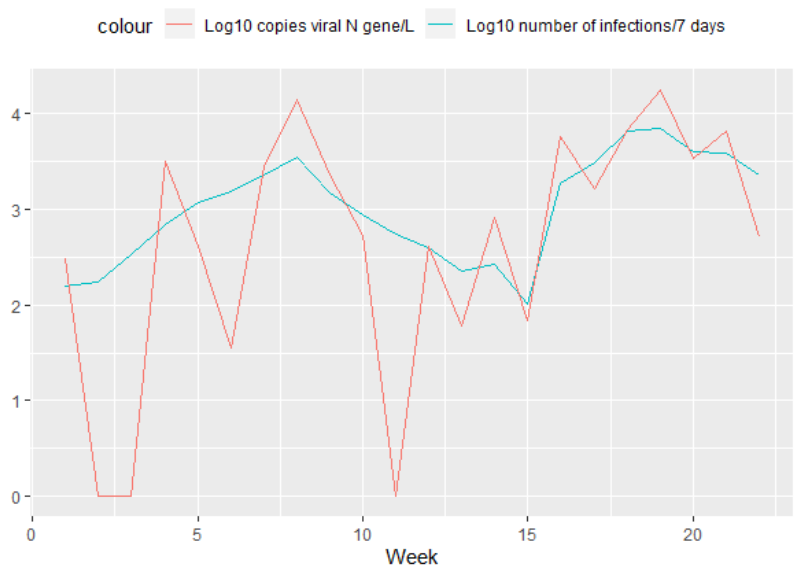
Figure 6. Log10 transformed amount of viral nucleic acid (N gene) detected in WWTP influent (red line) and the log10 transformed total number of infections that occurred during the week after the sampling (blue line).